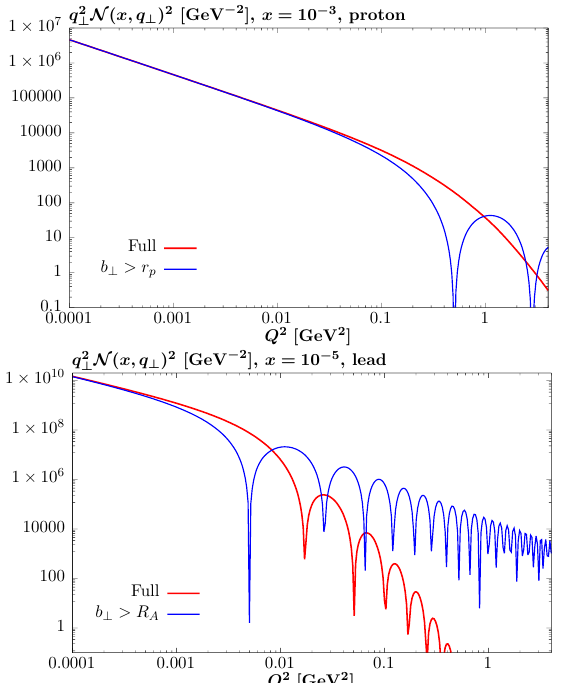
> R N ( x , q ⊥ ) 2 with and without the cut b imposed, ⊥ i ⊥ A (cid:112) (cid:112) = 5.02 s = 13 TeV ( s NN